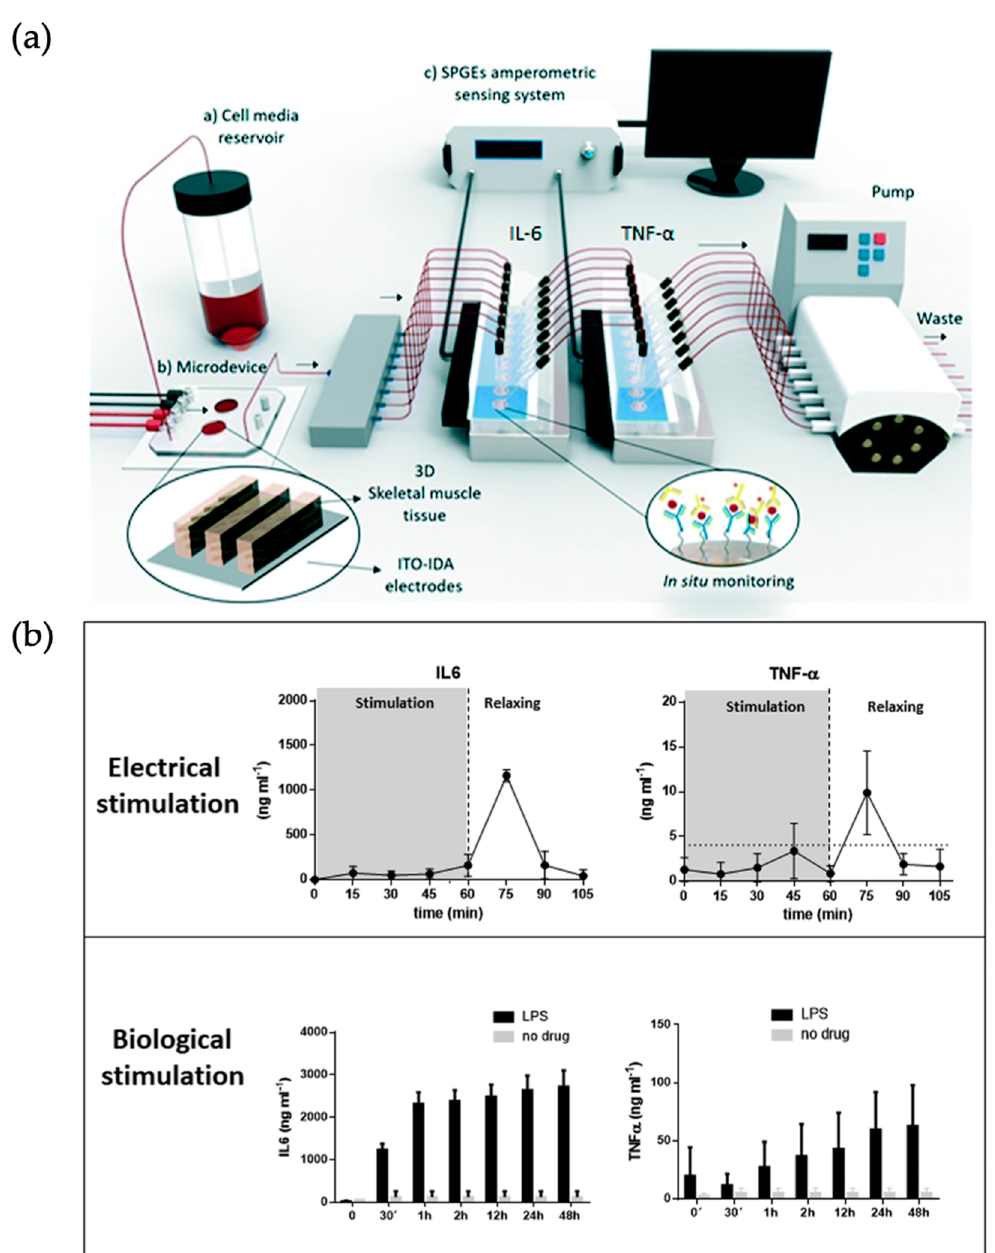
Figure 6. ( a ) Microfluidic setup for in vitro culture and stimulation of muscle tissue (murine C2C12 skeletal myoblasts) and subsequent analysis of IL-6 (Interleukin-6) and TNF- α (Tumor necrosis factor alpha) content. High-sensitivity screen-printed gold electrodes (SPGEs); indium tin oxide (ITO)- interdigitated array (IDA) electrodes ( b ) Increase in cytokine concentration was detected in the relaxation periods after electrical stimulation and also during stimulation with lipopolysaccharide (LPS). (Adapted from [50] with permission from The Royal Society of Chemistry).